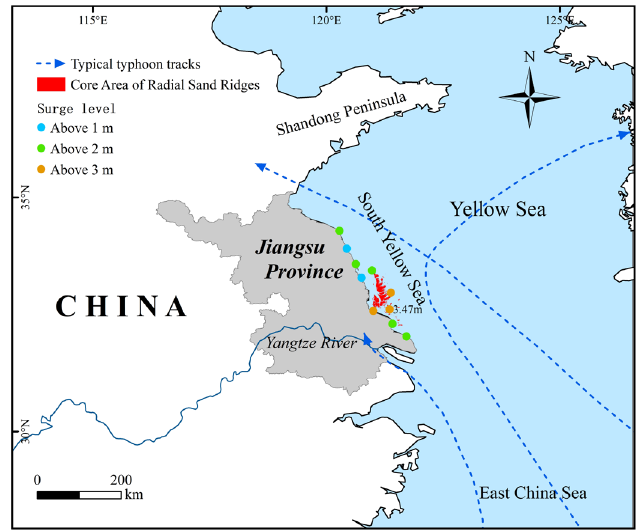
Figure 11. Typical typhoon tracks along the Jiangsu coast.